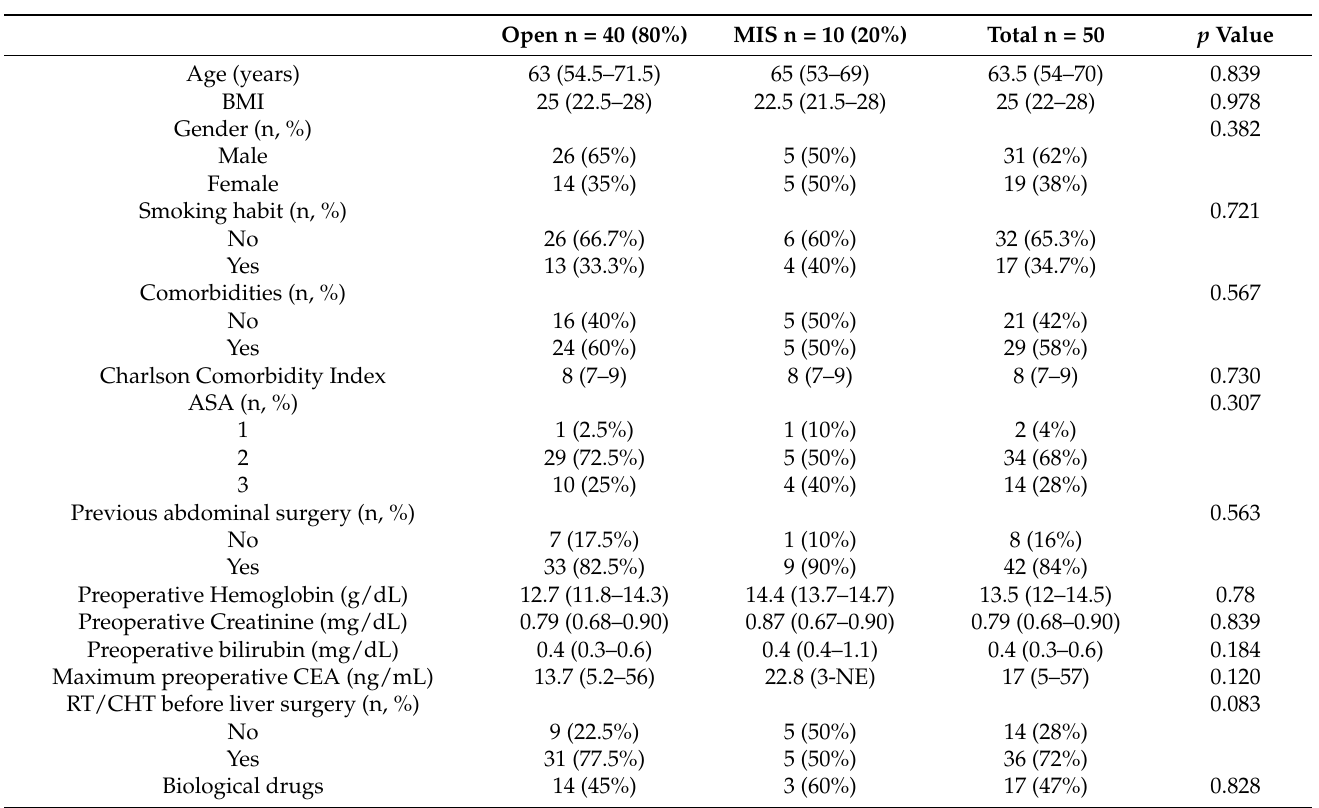
Table 1. Patient